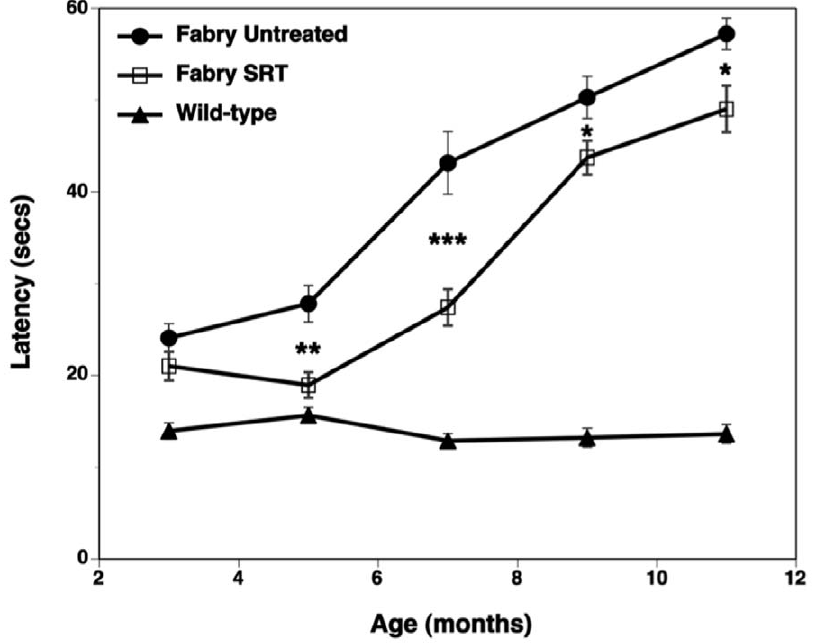
Figure 3. Substrate reduction therapy delays the onset of heat-insensitivity in Fabry mice. Treated Fabry mice received eliglustat tartrate as a component of their food beginning at 5 weeks of age. Mice were placed on a 55 u C hot-plate and the time for them to respond (latency) recorded. Latency was measured every two months from 3-months of age for untreated control Fabry ( wild-type mice ( m ). Statistics compare the treated to the untreated Fabry mice. Data are shown as mean 6 SEM (n=15 mice/time point). Statistics were determined using the Graphpad Prism software t test (*=p , 0.05; **=p , 0.01; ***=p , 0.001).